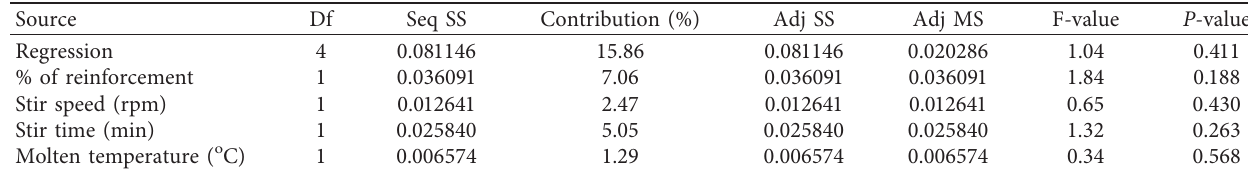
Figure 4: Residual plots for wear test. Table 6: Analysis of variance for wear test.